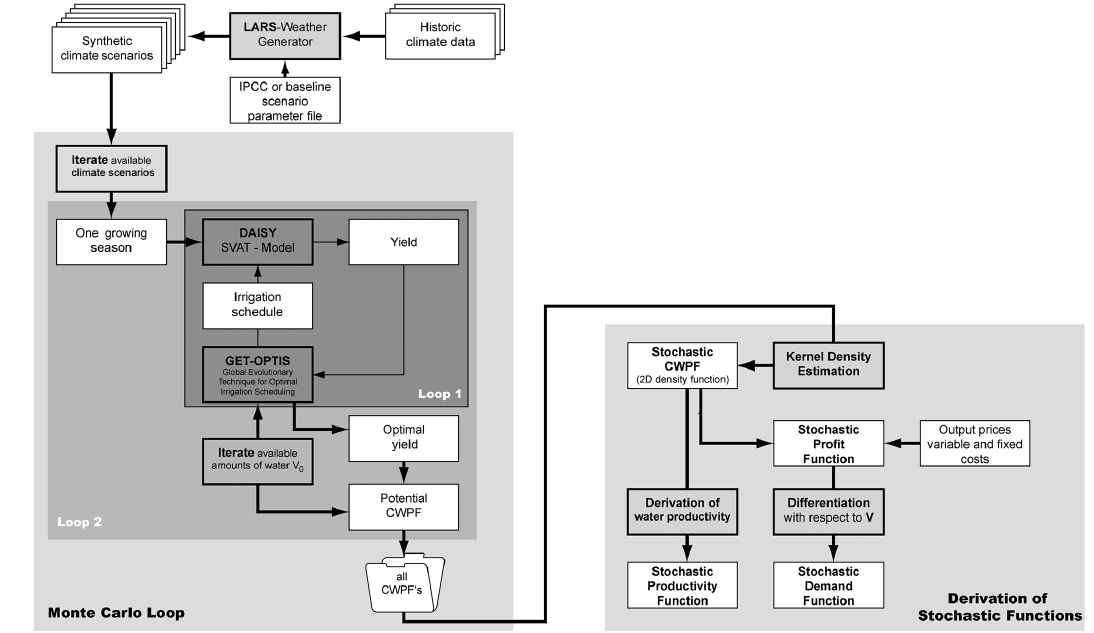
Figure 2. Layout of the stochastic framework for generating stochastic crop production functions on field